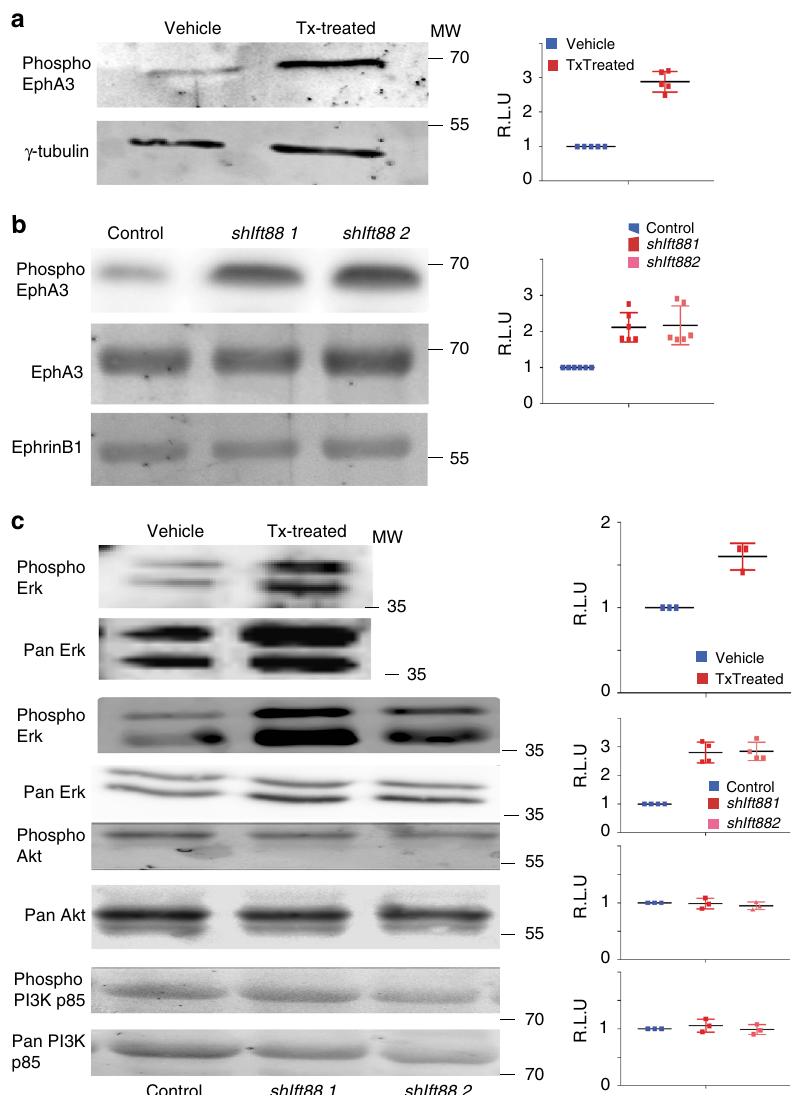
Fig. 2 EphA3 hyperphosphorylation in Ift88 -depleted β -cells. a pEphA3 (Tyr779) and γ -tubulin protein levels in Tx- and veh-treated islets and quanti fi cation ( n = 5, mean ± s.d.) b pEphA3 (Tyr779), EphA3, and EphrinB1 protein levels in shIft88 1 and 2 and scrambled RNA (control) and quanti fi cation. ( n = 6, mean ± s.d.) c Phosphorylated p44/42 ERK/MAPK (Thr202/Tyr204) and ERK/MAPK protein levels ( n = 4) in primary islets and MIN6m9 cells, pAkt (Ser437), Akt ( n = 3), phosphorylated p85 (Tyr458) and p85 protein levels ( n = 3) in MIN6m9 cells and quanti fi cation, mean ±